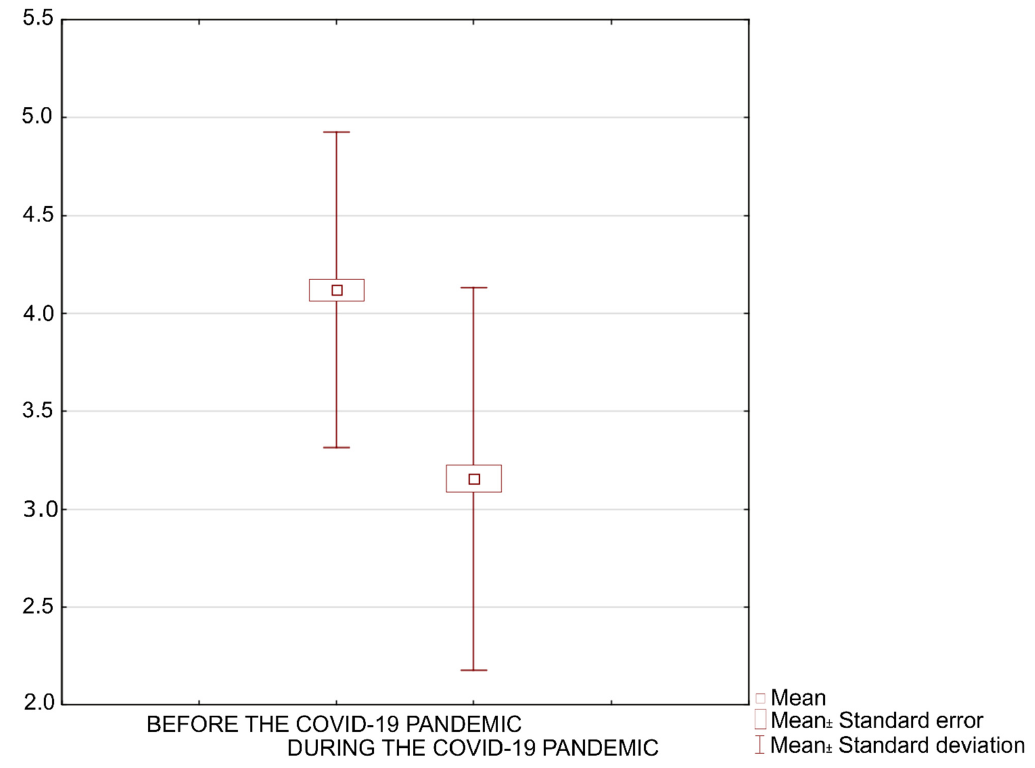
Figure 7. The respondents’ well-being before and during the COVID-19 pandemic. According to the self-assessment at the start of the second phase of the survey, the respondents’ sense of well-being decreased. The percentage of respondents reporting moderate and poor well-being increased (by 26.5% and 14%, respectively). Notably fewer respondents reported good or very good well-being (decrease by 27% and 18.5%, respec- tively). The biggest changes were observed among students who had declared good or very good well-being before the pandemic began; their sense of well-being usually dete- riorated to a medium level. Respondents who reported moderate or poor well-being be- fore the pandemic experienced its deterioration to a lesser extent (Table 2). The survey results also indicate that women experienced the pandemic-related stress to a greater ex- tent. Among women, an increase of moderate well-being (by ca. 30%) and decrease of good (by ca. 22%) and very good well-being (by ca. 30%) were the most conspicuous. Among men, the most noticeable change concerned very good well-being (decrease by ca. 19%) and moderate well-being (increase by ca. 15%).